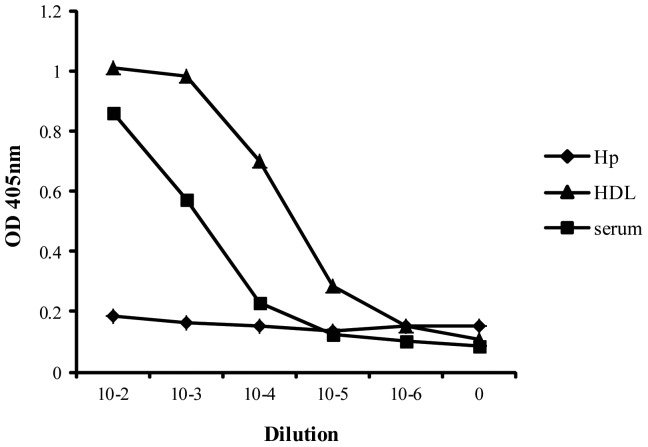
Specificity of Haptoglobin-related protein (Hpr) ELISA.To investigate whether the Hpr ELISA was specific for Hpr rather than Hp, it was performed using various dilutions pooled Hp (Sigma) (stock concentration = 100 µg/ml). To determine whether the ELISA detected Hpr in HDL, it was performed using various dilutions of a purified HDL fraction (stock concentration = 22.5 mg/ml total protein of which 300 µg/ml was found to be Hpr as determined using the Hpr standard). To show that the ELISA could detect Hpr in plasma, it was performed with dilutions of pooled sera (Courtesy of John Radcliffe blood bank). All results are means of duplicate readings and are minus readings from blank wells.